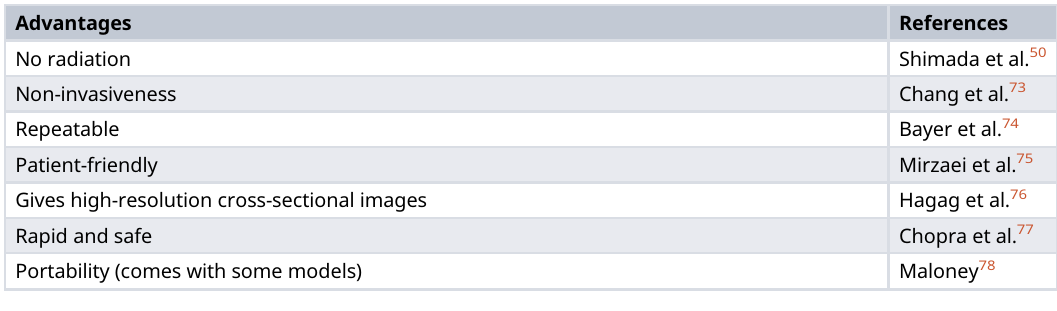
Table 2. Showing potential disadvantages of